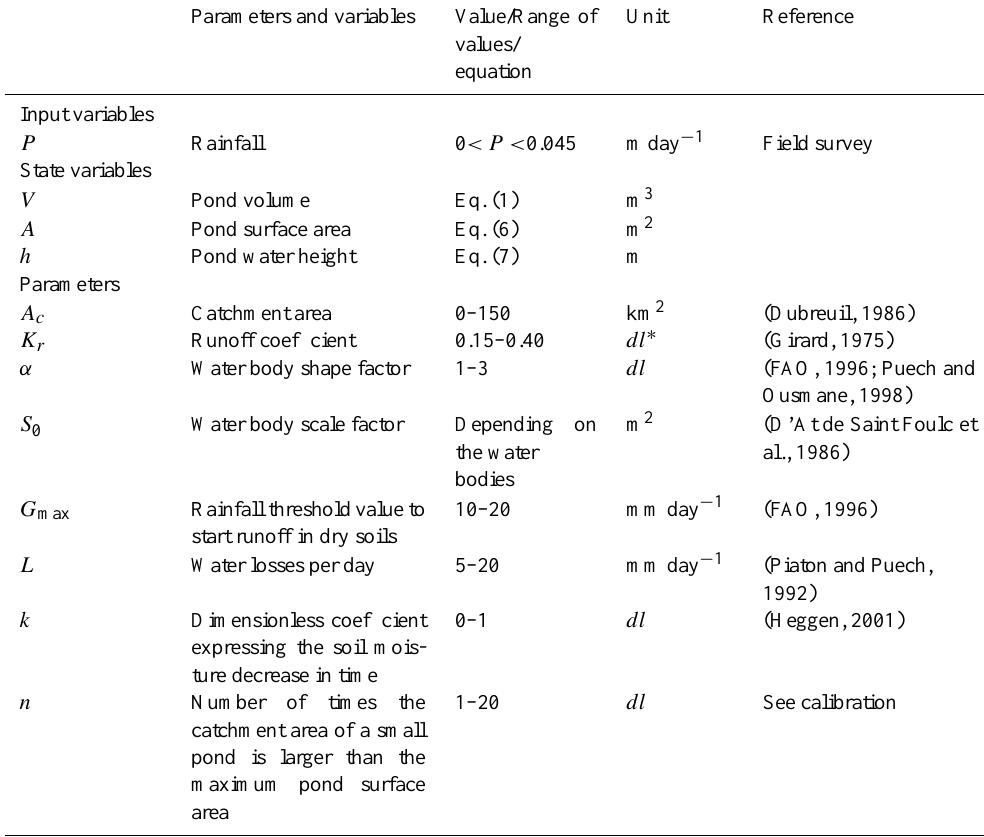
Table 2. Parameters and variables of the hydrologic pond model.